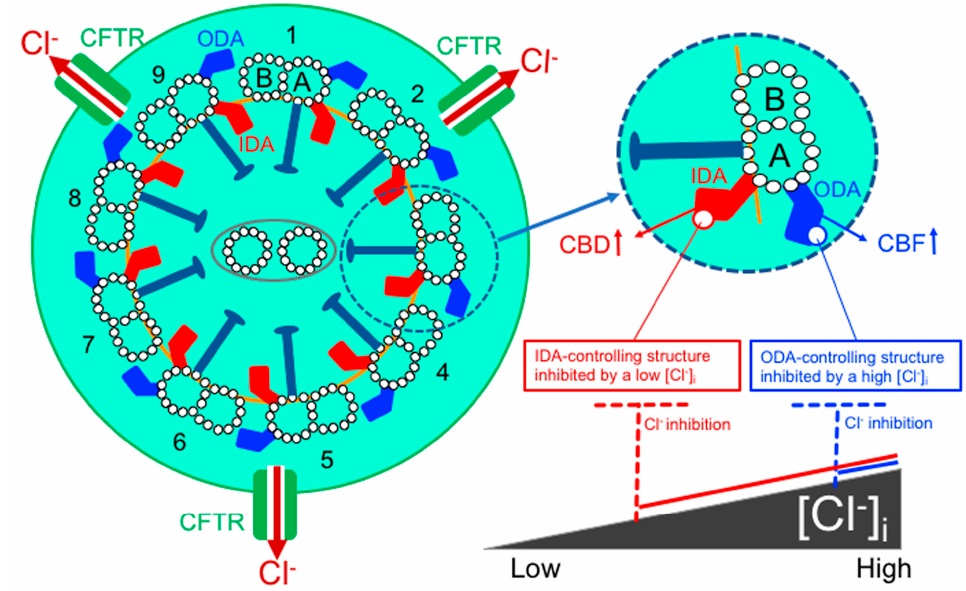
Figure 8. Cl − modulation of ciliary beating in cHNECs. Ciliary membrane express CFTR [20]. Inner dynein arms (IDAs) control waveform including CBD and outer dynein arms (ODAs) control CBF. Axonemal structures controlling IDAs and ODAs appear to have Cl − sensors. The sensors binding Cl − may inhibit the axonemal structures controlling IDAs or ODAs leading to CBD decrease and CBF decrease. [Cl − ] i inhibiting IDA-controlling structures may be lower than that inhibiting ODA-controlling structures. Under the resting condition, ODAs are activated and IDAs are partly inactivated. At a lower [Cl − ] i , ODAs continue to be active and IDAs are activated. At a higher [Cl − ] i, both ODAs and IDAs are inactivated.